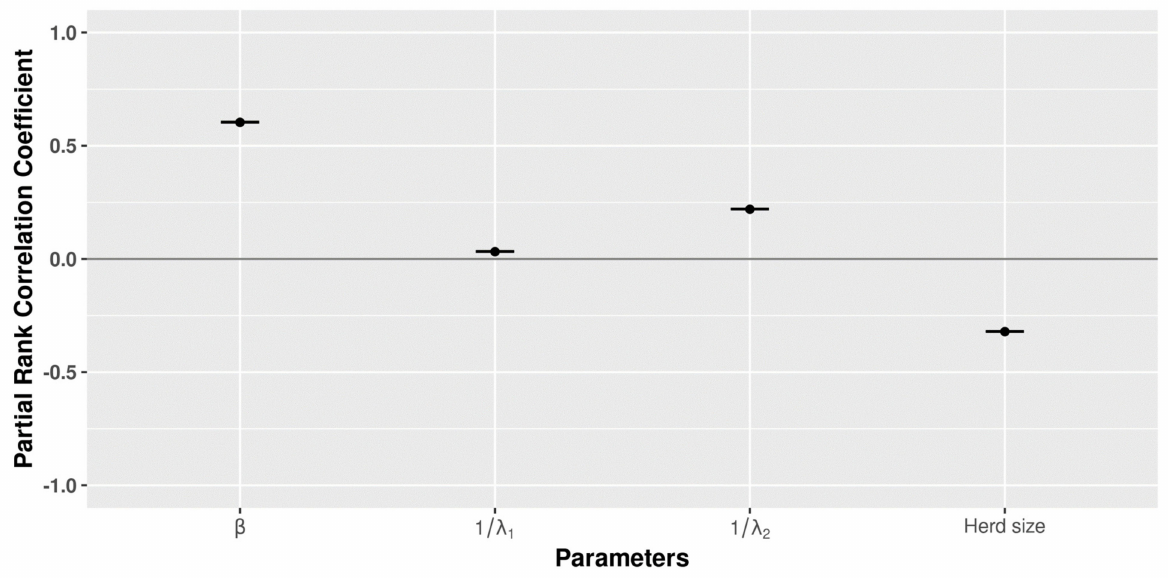
Figure 9. Latin Hypercube Sampling-Partial Rank Correlation Coefficients (LHS-PRCC) sensitivity analysis (1000 samples and 100 replicates) considering the impact of varying values for parameters β , 1/ λ 1 , 1/ λ 2 , and herd size on the within-herd prevalence with a PRCC, significantly ( p < 0.05).